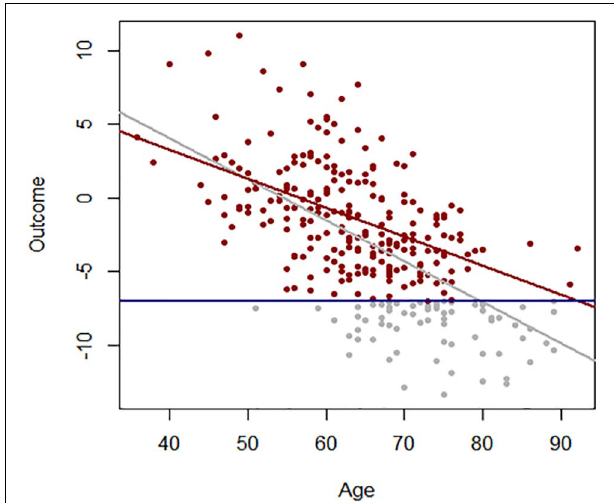
FIGURE 3 | Association between age and a hypothetical outcome when all values of the outcome are observed (gray) and when values below a threshold (blue line) more frequently exceeded at older ages are not observed